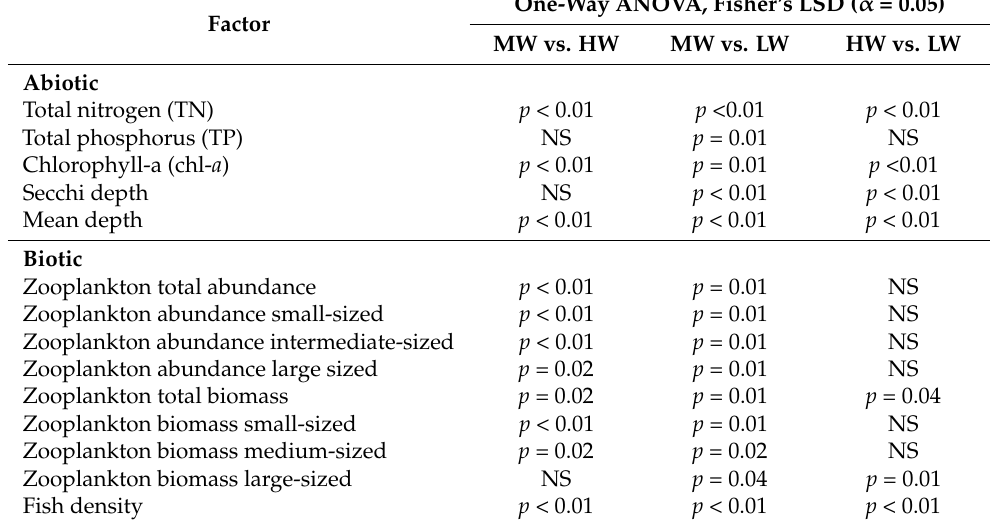
Table 3. One-way analysis of variance (ANOVA) with Fisher’s least significant different (LSD) for abiotic and biotic factors across the three hydrological periods in Lake Tempe: moderate-water (MW), high-water (HW), and low-water (LW). The differences are significant when p = 0.05; NS = no significant differences. One-Way ANOVA, Fisher’s LSD ( α = 0.05) Factor MW vs. HW MW vs. LW HW vs.